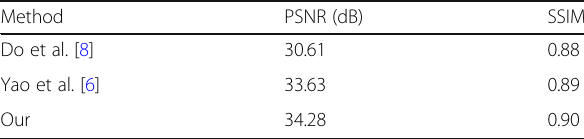
Table 4 Time continuity comparison for “ Ballet ”